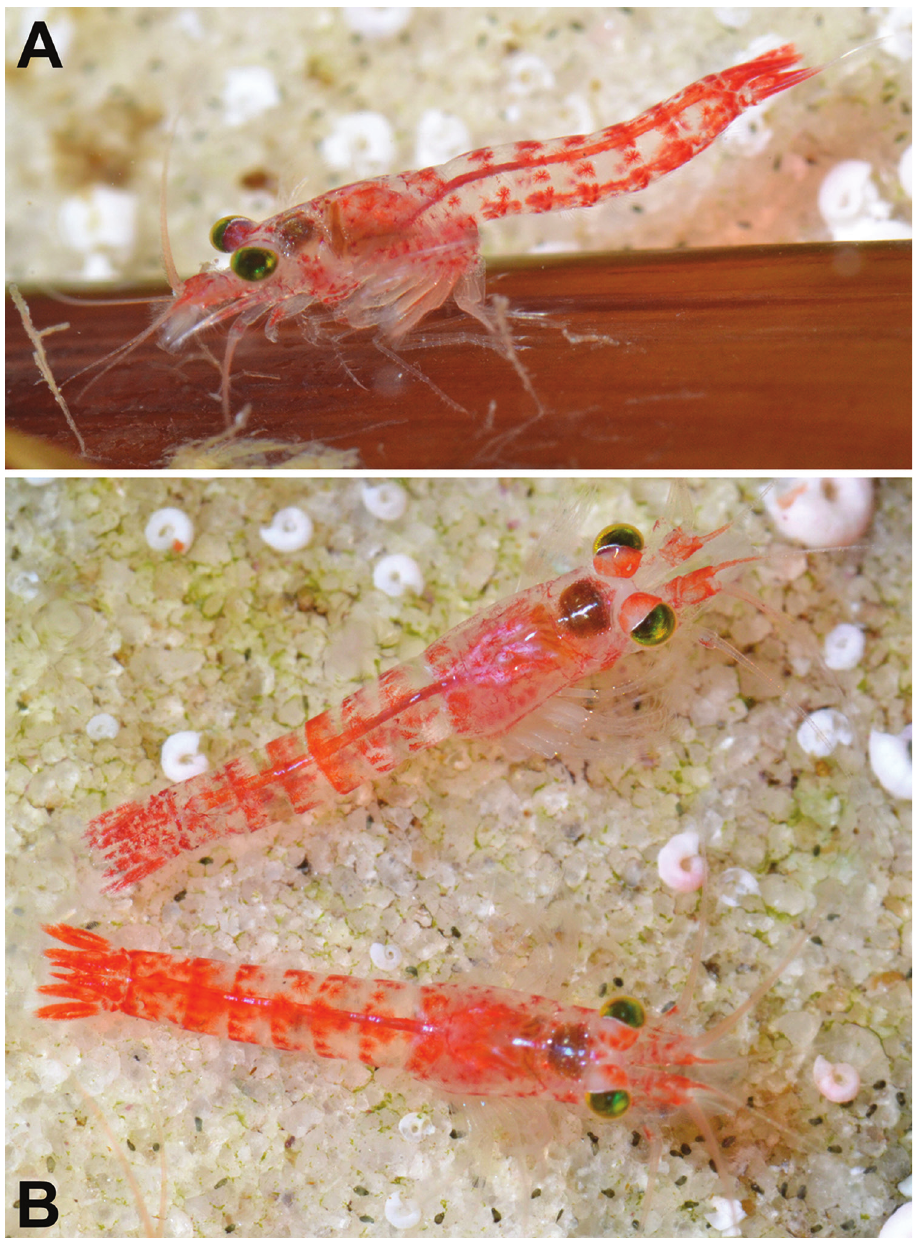
Figure 1. Ex-situ microphotographs of Heteromysis cancelli sp. n. from False Bay, Simonstown, Cape Peninsula, South Africa; adult males with 6–7 mm body length in lateral ( A ) or in dorsal view ( B ), re- spectively. Aquarium photos by C.L.